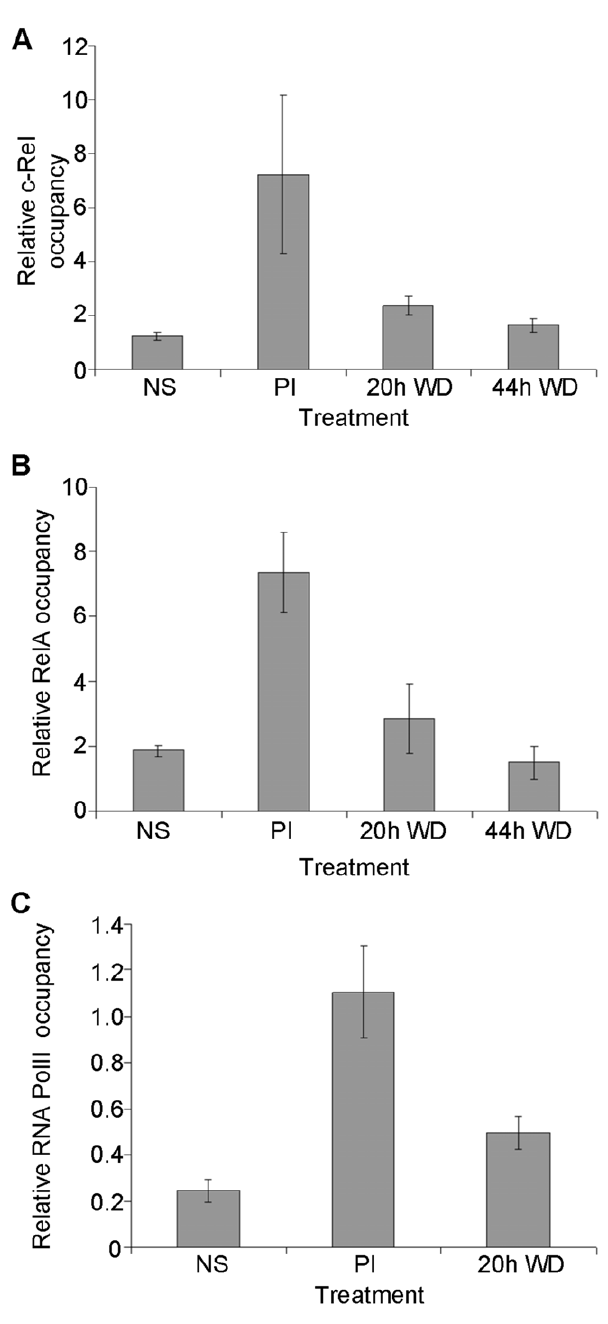
Figure 3. NF- k B and RNA Polymerase II occupy the active GM- CSF promoter. (A) c-Rel (B) RelA and (C) RNA polymerase II occupancy was determined at the GM-CSF promoter by ChIP analysis of unstimulated EL-4 T cells (NS), cells stimulated for 4 h with PI (PI) and cells in which the stimulus was withdrawn (WD) for the indicated times. Occupancy levels are shown relative to the inactive rhodopsin promoter. The mean and standard error of three independent experiments is